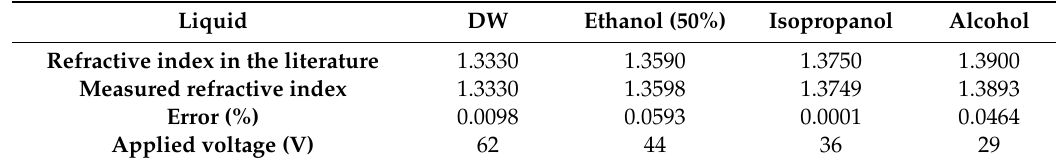
Table 3. Refractive index and error measured with di ff erent